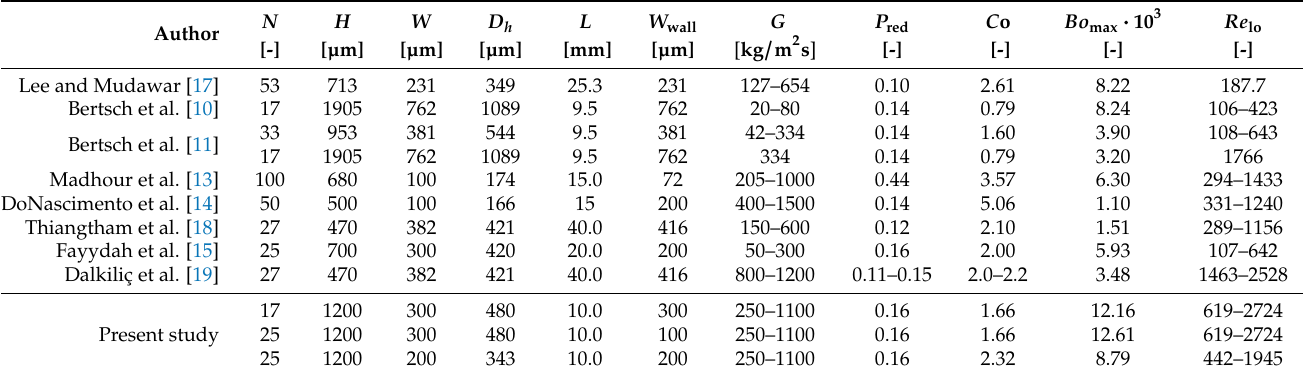
Table 1. List of previously investigated conditions in flow boiling of R-134a in copper multi-microchannel and nominal test conditions of the present